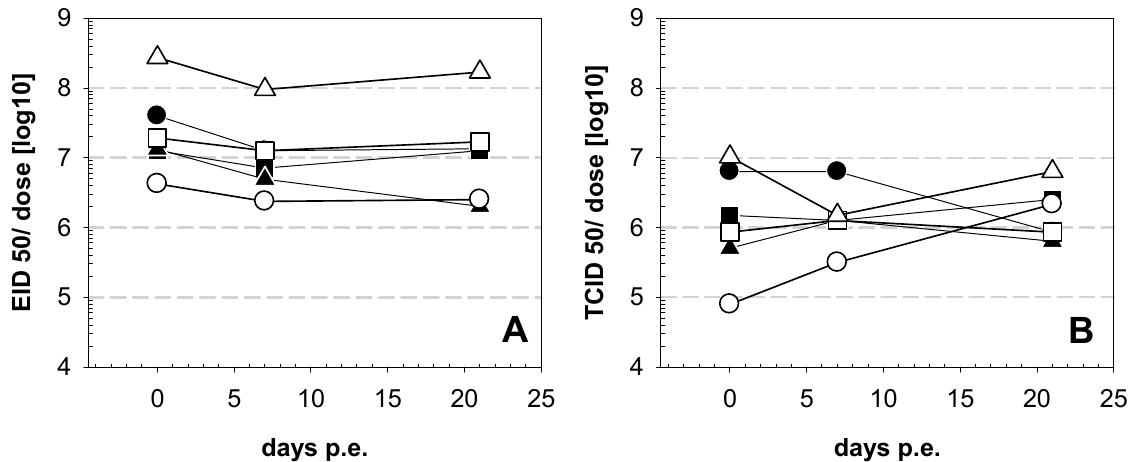
Figure 1. Stability of commercial Newcastle disease (ND) vaccines stored at 4 °C. Lyophilized original vaccine vials were stored at 4 °C and at indicated time points after the start of the experiments vials were investigated for infectivity on embryonatedspecific pathogen free (SPF) chicken eggs ( A ) and on LMHcells ( B ). Symbols represent vaccine A ( ● ), vaccine B ( ■ ), vaccine C ( ▲ ), vaccine D ( ○ ) vaccine E ( □ ), and vaccine F ( ∆ ).